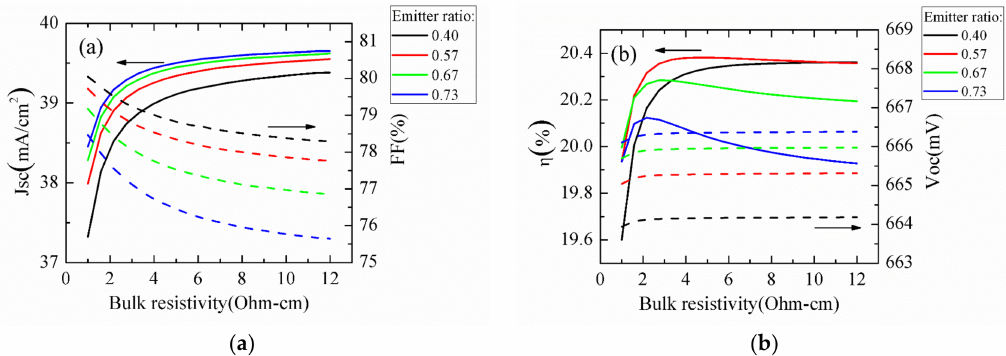
Figure 4. Solar cell electrical parameters with different emitter width ratio and bulk resistivity values. ( a ) Change in J sc and FF with different emitter width ratio and bulk resistivity values; ( b ) Change in Efficiency and V oc with different emitter width ratio and bulk resistivity